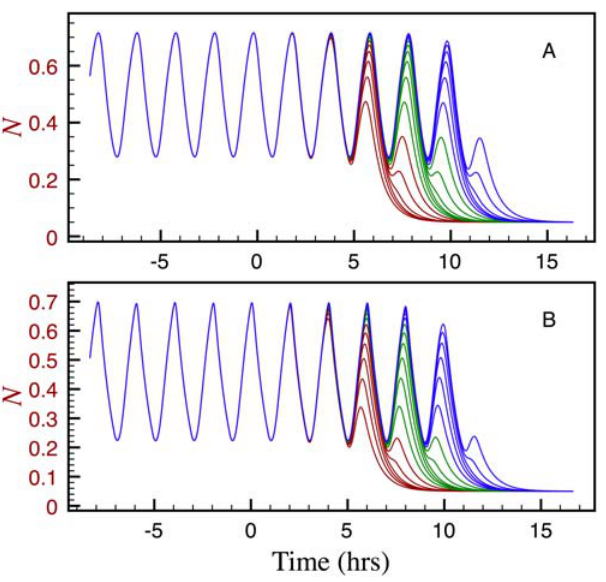
Figure 4. Plots of Nvs.t representing the time-evolution of 18 cells distributed along the PSM, with a separation of 20 min between adjacent cells, with k evolving as in Figures 2C and 2D. Under the assumption that the tail bud recedes at constant velocity and keeps leaving cells behind in a steady fashion, the distance between two PSM cells is proportional to the time difference elapsed since leaving the TB. The simulations plotted in A were carried using the model given by Equations (1) and (3). For the simulations plotted in B we employed the model given by Equations (4) and (5), which include additional delays associated to the interactions between the Notch and FGF/Wnt pathways. In both cases, the curves corresponding to cells closer to the TB stop oscillating latter. For more clarity, the curves corresponding to the first, second and third sets of six cells are plotted in red, green, and blue, respectively. All the parameters were set to the values estimated in the section on parameter estimation. the segmentation of PSM cells into the blocks that will form somites.